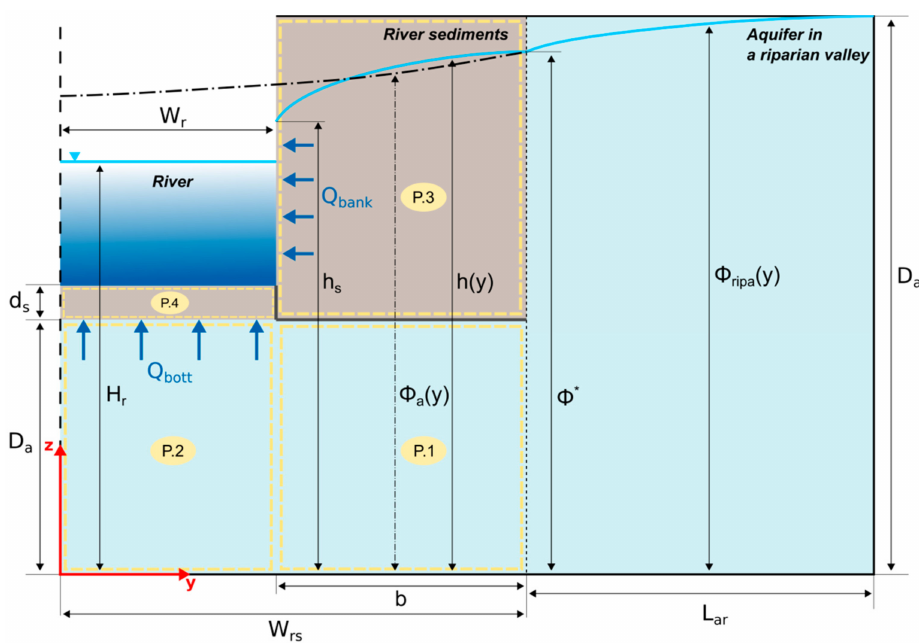
Figure 3. Flow subdomains: P.1 and P.2, in aquifer under river sediments; P.3, river sediments right / left of the river bank; P.4, river sediments under river bottom; (y, z), general system of